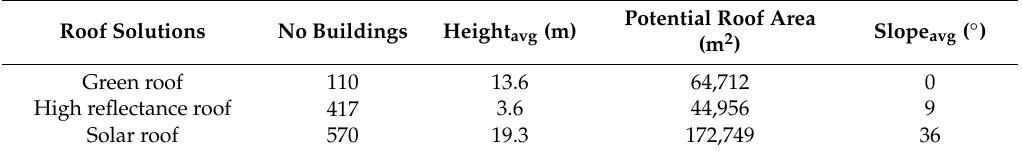
Figure 6. District of Turin with a dimension of 1 km 2 : ( a ) Building block classification according to three classes of air quality conditions (green, good; yellow, acceptable, red, bad) [23]; ( b ) analysis of roof potential and feasibility of smart solutions: Green, high-reflectance, and solar roofs. Table 5. Buildings’